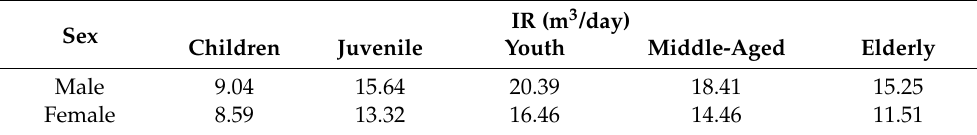
Table A2. Description of the four routes.